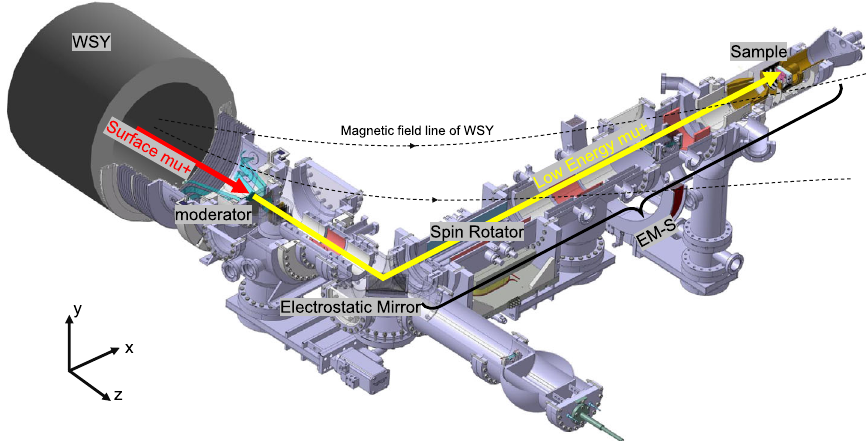
FIG. 10. Profile of the LEM facility, showing the section EM-S between the electrostatic mirror (EM) and the position of the sample (S), where the LE- μ SR experiments are carried out.